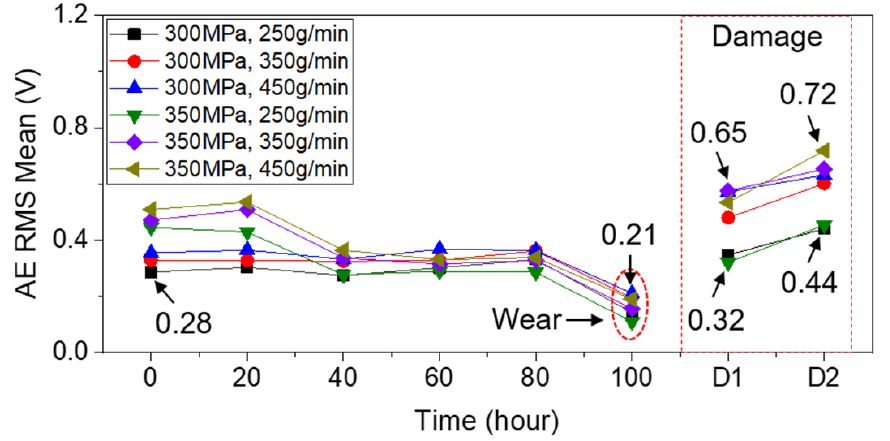
Figure 10. Comparison of mean AE RMS values by waterjet pressure and abrasive feed rate. After 80 h, regardless of the waterjet pressure or abrasive feed rate, the nozzle wall wore slowly and began to expand. At this time, if nozzle expansion continues, the pressure